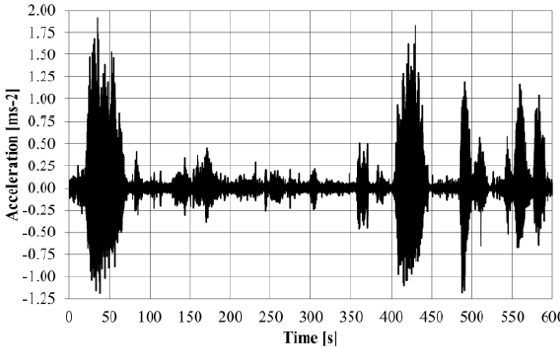
Figure 6. Maximum platform acceleration in 2013 [2].